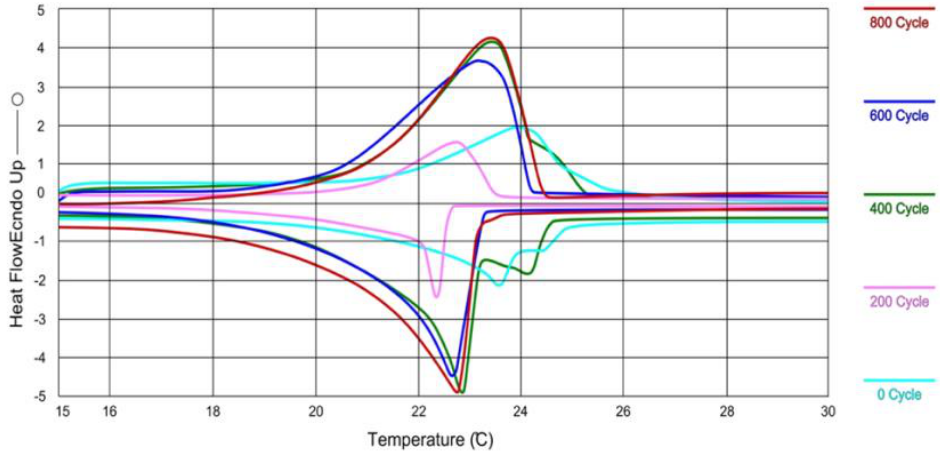
Figure 6. Comparison of the DSC curves of micro-encapsulated BS PCMs subjected to 0, 200, 400, 600 and 800 thermal cycles [75].